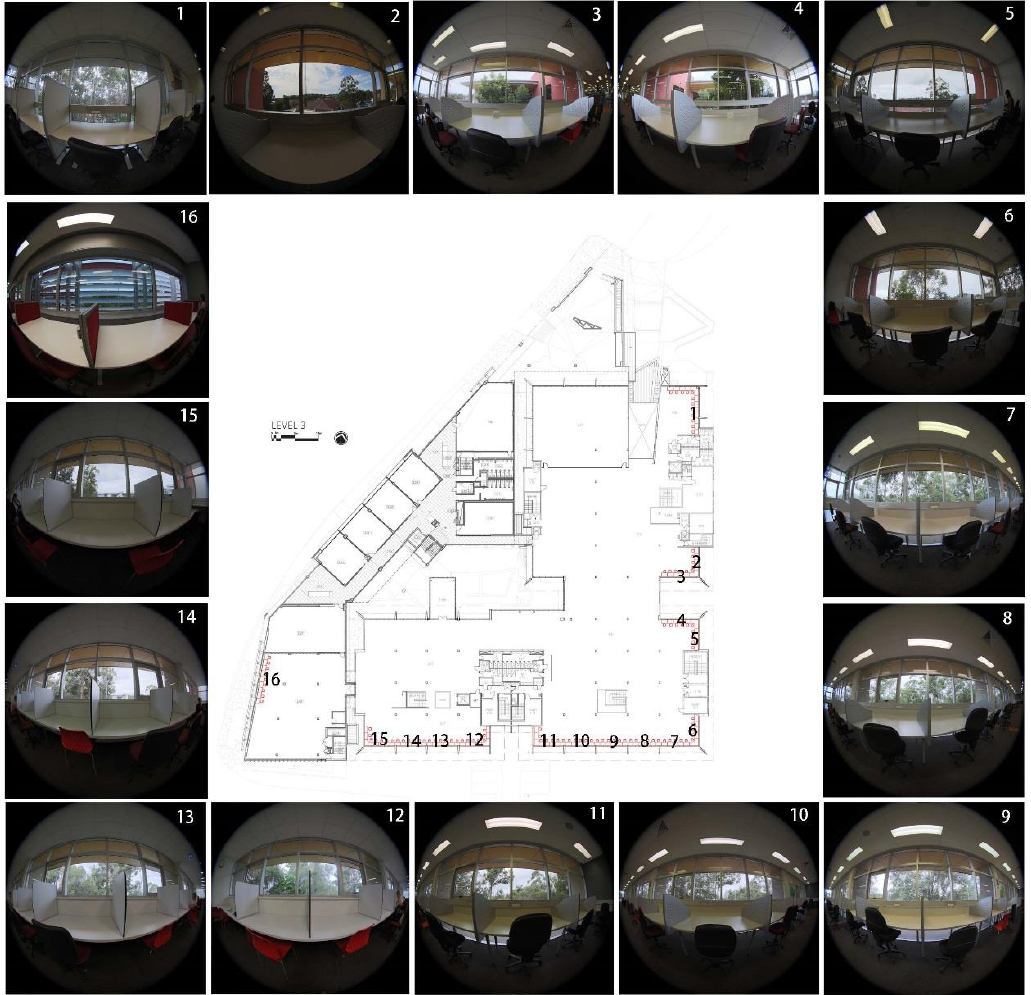
Figure 6. The 16 locations where the Passive Infrared (PIR) motion sensors were installed (the pictures show the outside views at those locations).